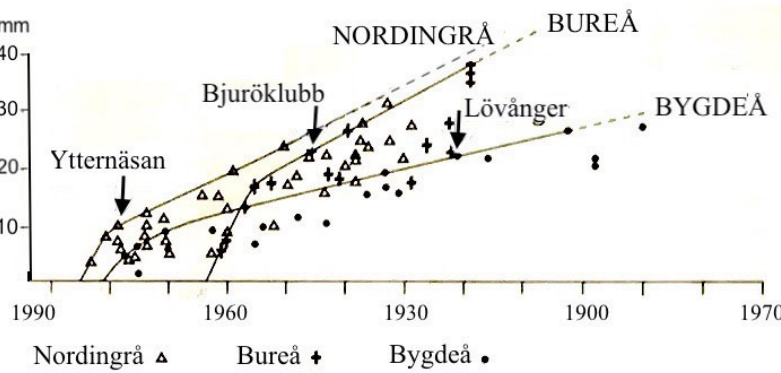
Figure 4. Growth curves for Rhizocarpon alpicola constructed in graveyards by the Bothnian Gulf, Sweden: at Nordingrå near Bådermalen; Bygdeå 5 km inland and 180 km to the north; and at Bureå lying on the shore 70 km further north again. Arrowed: Ytternäsan lighthouse steps repaired in 1979, construction at Bjoröklubb in 1945, and a memorial to a royal visit at Lövånger in 1921 [67].